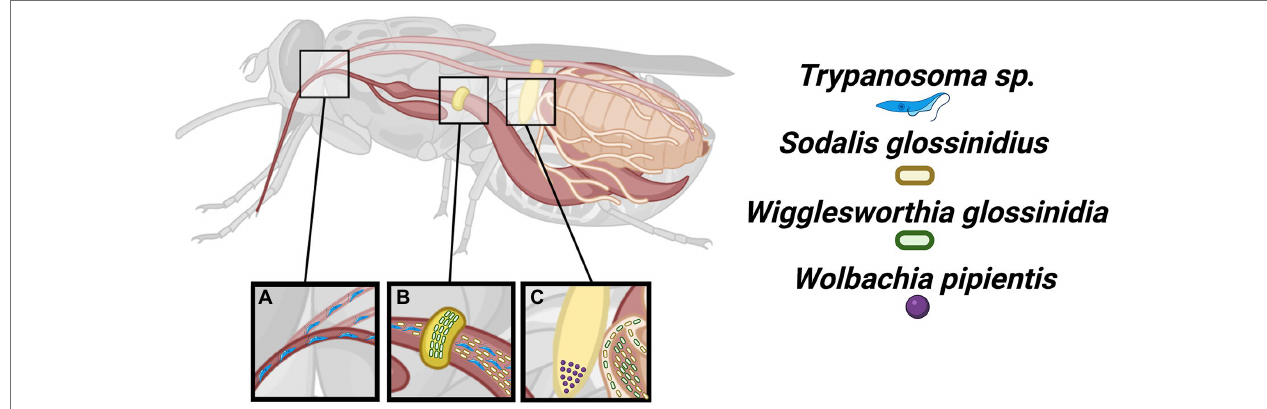
FIGURE 1 | Localization of tsetse microbiota. The tsetse fly is the sole vector of most African trypanosomes. (A) These protozoan parasites are introduced into the tsetse fly by an infected blood meal where developmental differentiation, recombination, and migration to the salivary glands occur. (B) The Wigglesworthia and Sodalis symbionts may be found within the bacteriome and gut, respectively. (C) The Wigglesworthia , Sodalis , and Wolbachia symbionts are vertically transmitted. The Wigglesworthia and Sodalis bacteria specifically use milk gland infections while Wolbachia infects ovaries for transgenerational